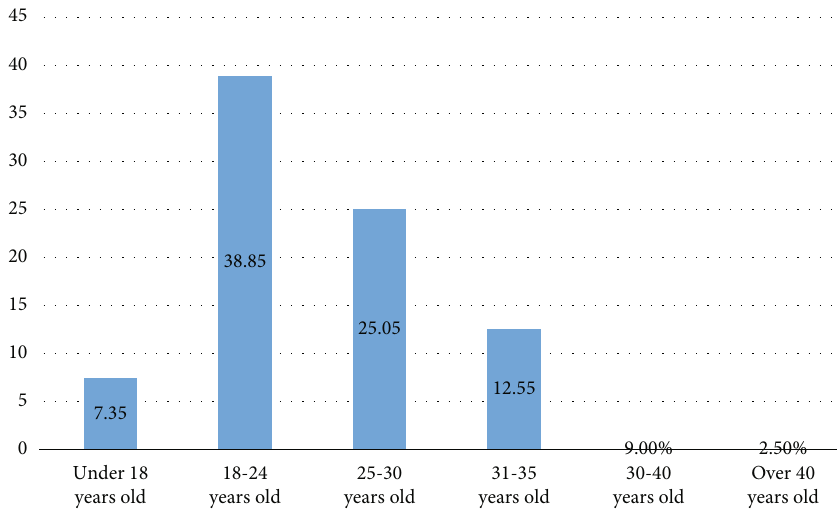
Figure 6: Internet users in di ff erent age